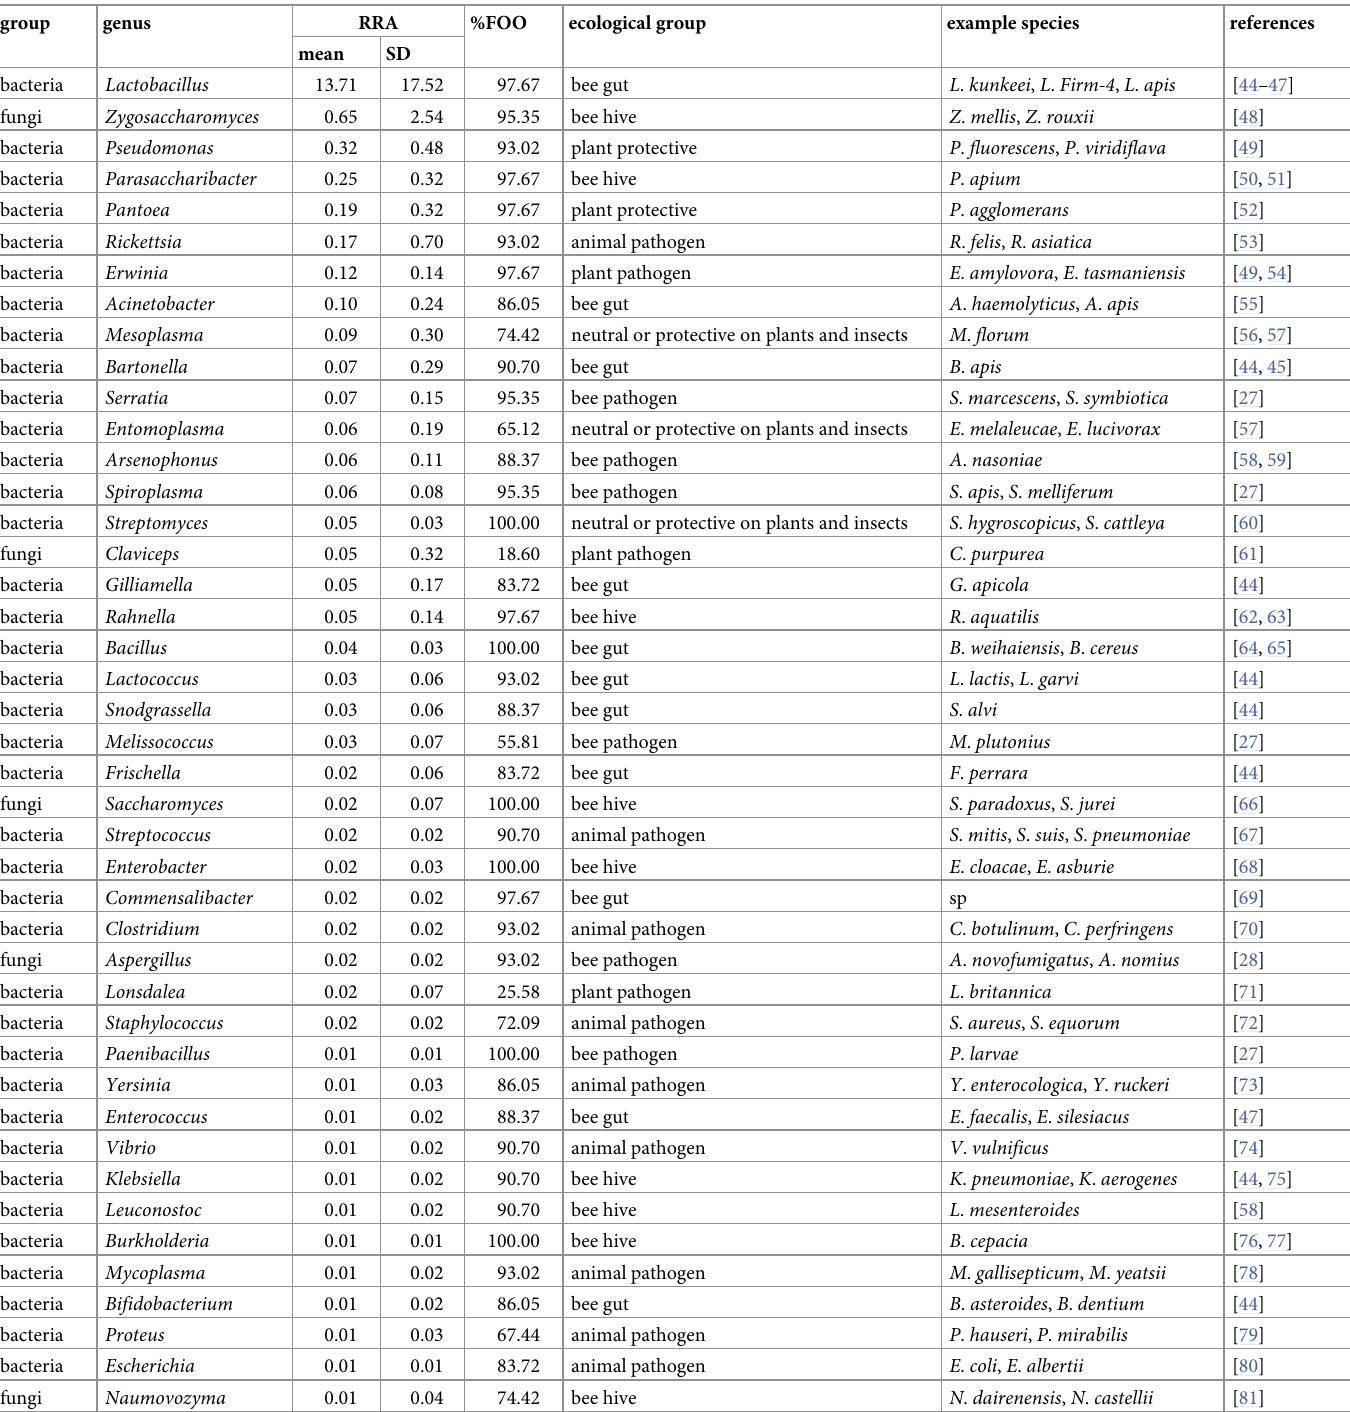
Table 1. The relatively most abundant microbial genera with their ecological group based on